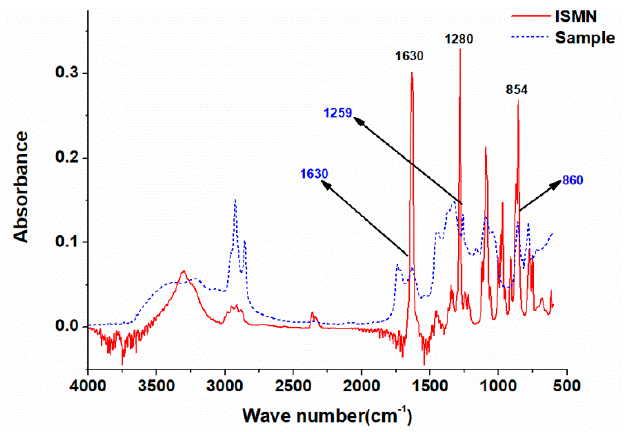
Figure 6. Fourier transform infrared spectrometry (FTIR) spectra of the sample and isosorbide 5-mononitrate (ISMN) standard.